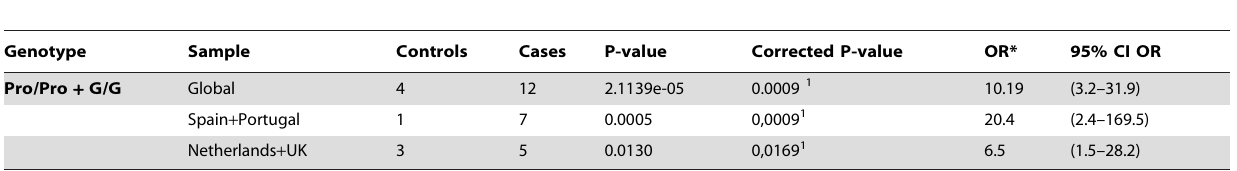
Table 5. Genetic interaction between p53 Pro72Arg SNP (rs1042522) and MDM2 T309G SNP (rs2279744) in the global sample and in sub-samples from different